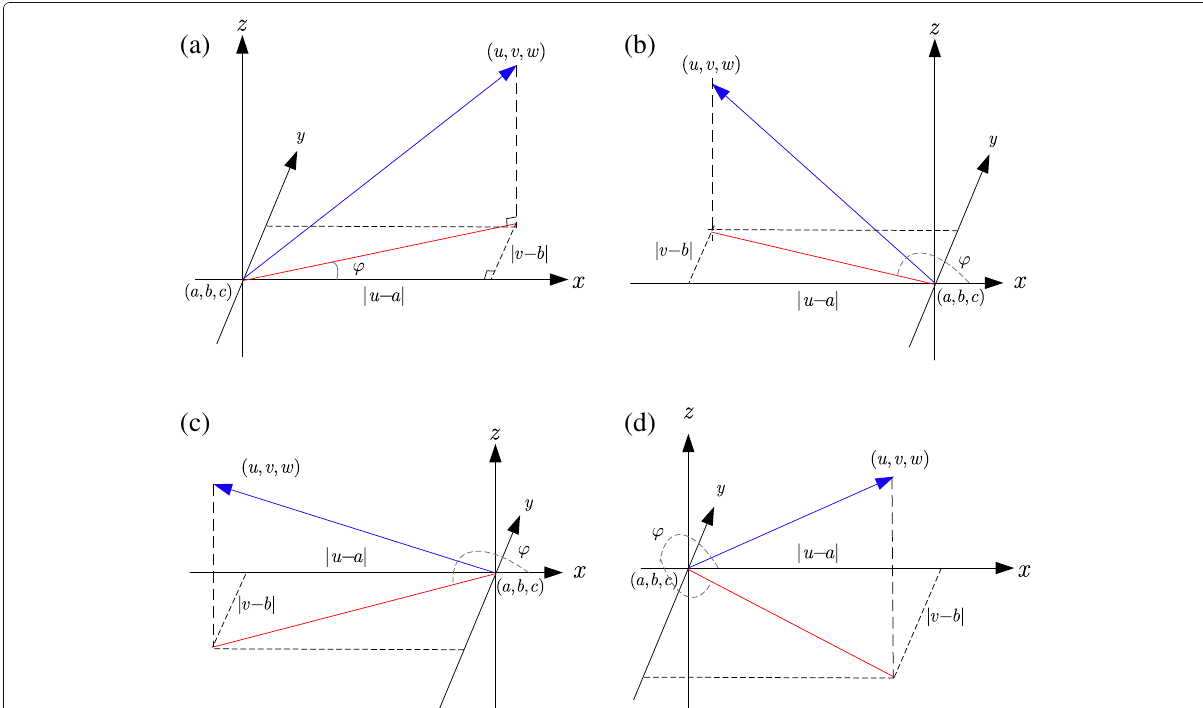
Fig. 2 The azimuth angle when LED’s projection locates in different quadrants of the XY plane. a 1st quadrant. b 2nd quadrant. c 3rd quadrant. d 4th